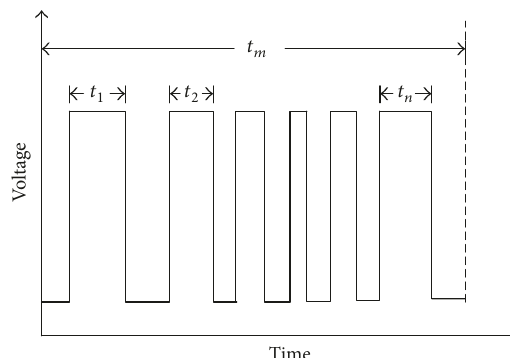
Figure 2: Ideal output voltage signals for a series of bubbles.